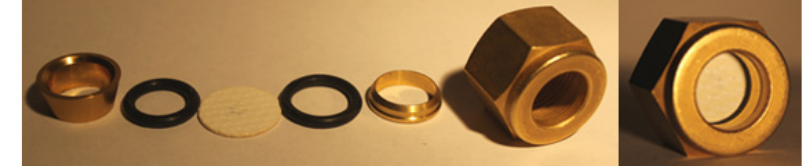
Figure 3. Assembly structure for the leak test of various material